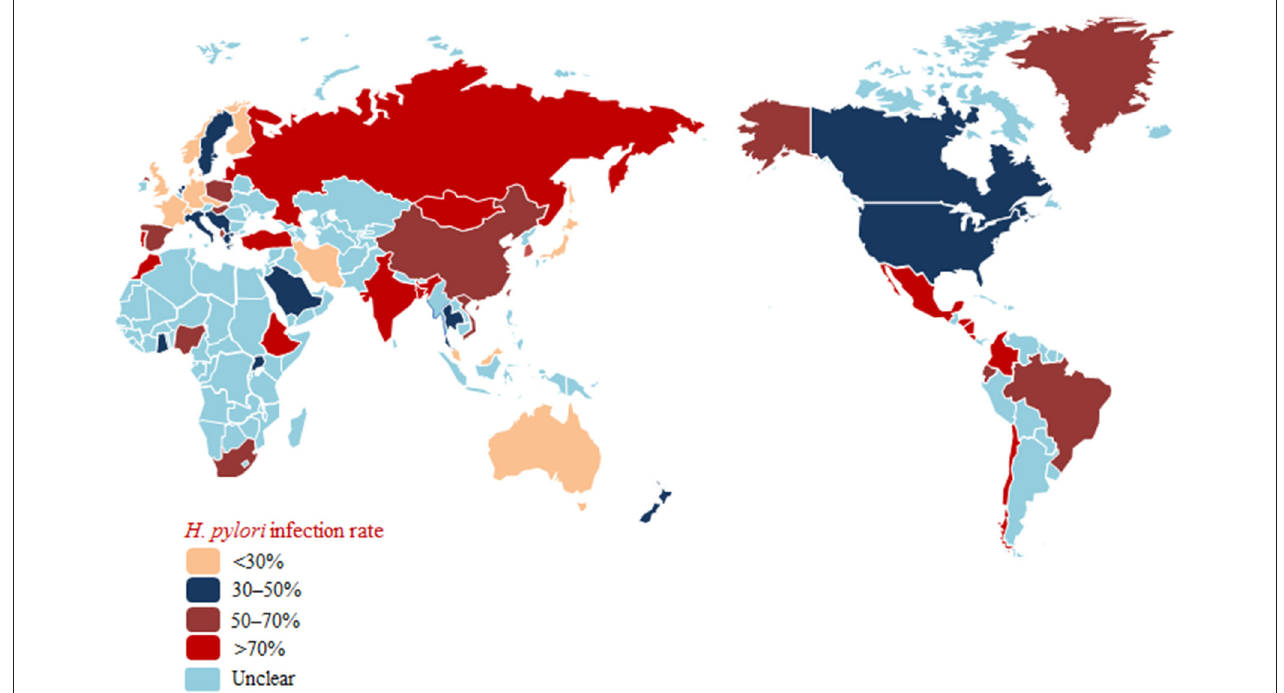
FIGURE 1 | Helicobacter pylori prevalence in populations worldwide.